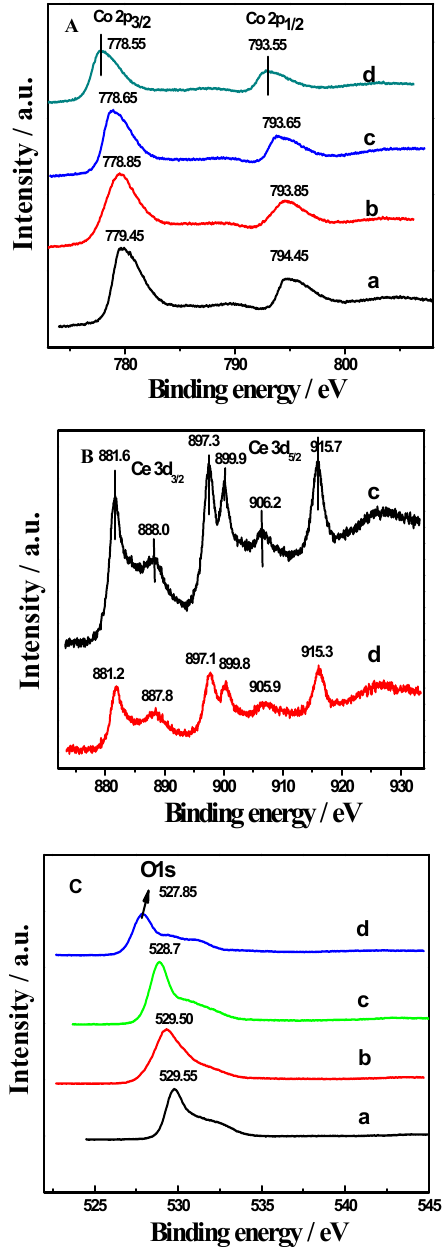
Figure 3. X ‐ ray photoelectron spectroscopy (XPS) spectra of ( A ) Co2p; ( B ) Ce3d; and ( C ) O1s for the composite metal ‐ oxide catalysts: ( a ) Co 3 O 4 ; ( b ) Mg 0.2 Co 0.8 Co 2 O 4 ; ( c ) Ce 0.05 Co 0.95 Co 2 O 4 ; ( d ) Mg 0.025 Ce 0.05 Co 0.925 Co 2 O 4 .